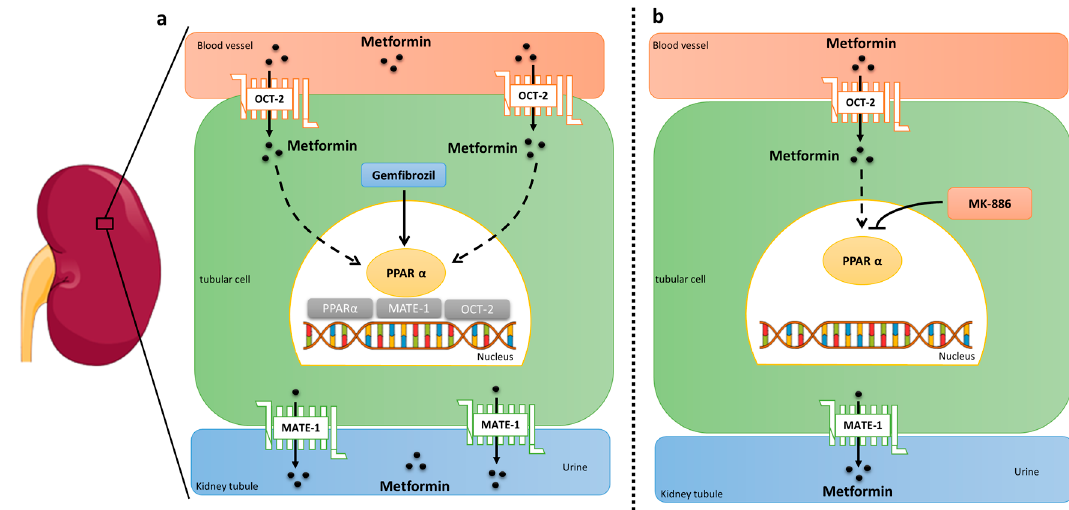
Figure 4. Summary of the e ff ects of metformin in the modulation of OCT-2 and MATE-1 transporters via PPAR α . ( a ) Metformin was able to increase the expression of PPAR α , OCT-2, and MATE-1. Gemfibrozil, a PPAR α agonist, increases the expression of PPAR α , OCT-2, and MATE-1. ( b ) The PPAR α antagonist, MK-886, abrogated the metformin-induced regulation of PPAR α and OCT-2 and reduced the expression of MATE-1.